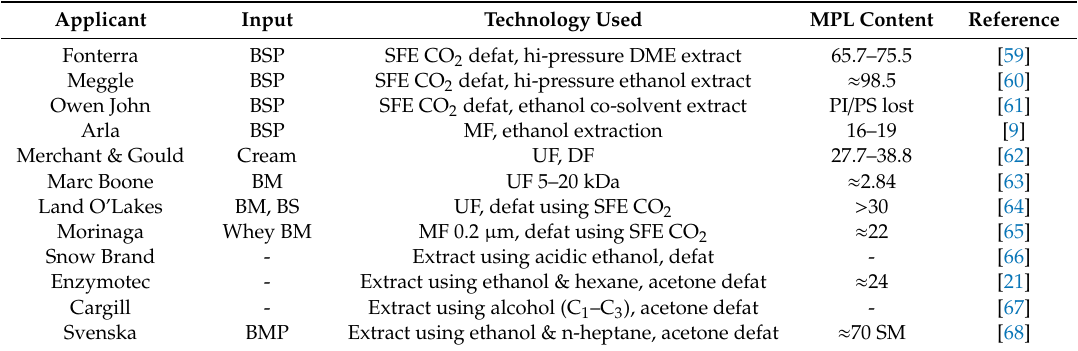
Table 2. Proprietary / patented manufacturing technologies of milk phospholipids (kg / 100 kg